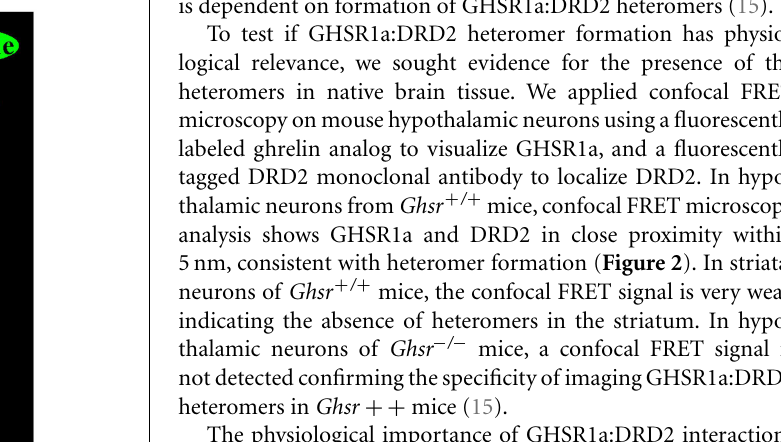
FIGURE 2 | In hypothalamic neurons GHSR1a and DRD2 form heteromers . Hypothalamic brain slices from Ghsr + / + mice were used to identify GHSR1a:DRD2 heteromers. Confocal FRET microscopy show that